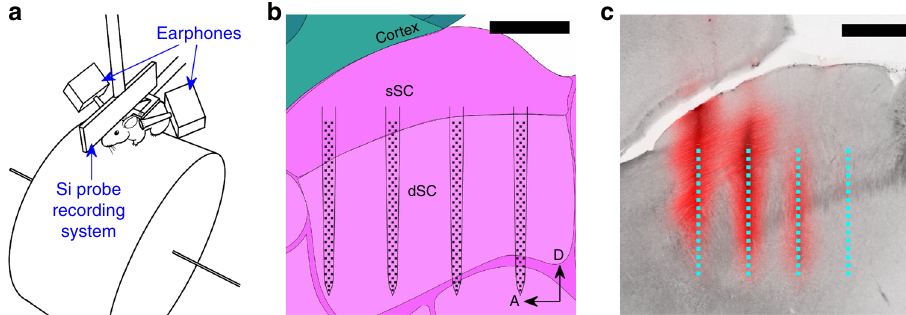
Fig. 1 Experimental setup. a An illustration of the virtual auditory space (VAS) stimulus and electrophysiology recording setup. During the recording, the head- fi xed mouse can run freely on a cylindrical treadmill, while motion is recorded by a rotary encoder. Auditory stimuli are delivered through a pair of earphones near the mouse ’ s ears. The entire setup is enclosed in an anechoic chamber. b A schematic of a 256-electrode silicon probe in the superior colliculus (SC; sagittal plane). The background image is from Allen Mouse Brain Reference Atlas 54 . sSC: super fi cial SC; dSC: deep SC; A: anterior; D: dorsal. The scale bar is 500 µ m. c A photograph of a sagittal section of the SC and the fl uorescent tracing of DiI (red channel) that was coated on the back of the probe shanks. The dotted cyan lines indicate the active areas of the probe during the recording, reconstructed from the DiI traces (the location of the rightmost shank was inferred by a DiI trace in the adjacent slice). The four shanks with a 400- µ m pitch nicely match the anteroposterior extent of the SC. The scale bar is 500 µ